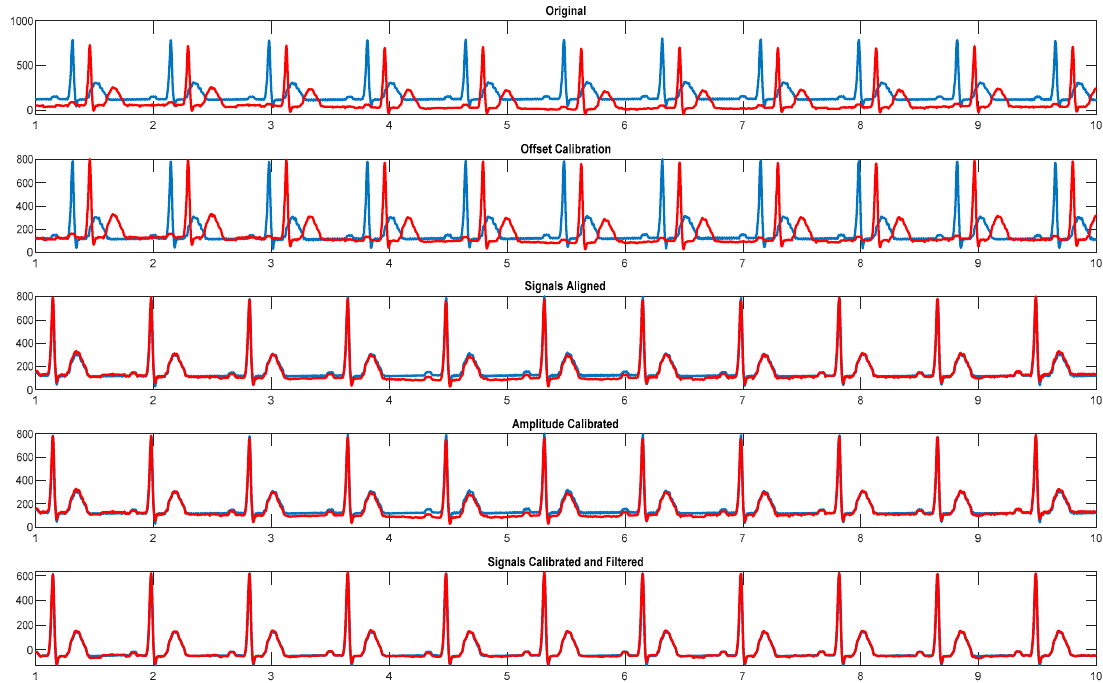
Figure 16. Calibration of the arm-ECG sensor against a commercial high-resolution reference device. Table 4. Calibration metrics.